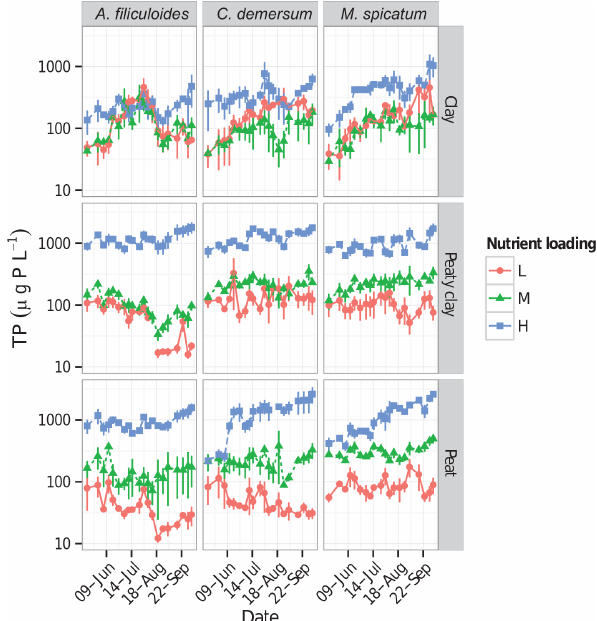
Figure 1. Surface water total P (TP) concentrations sub- jected to different nutrient loadings (L: 0.43mgPm − 2 d − 1 ; M: 21.4mgPm − 2 d − 1 ; H: 85.7mgPm − 2 d − 1 ) in mesocosms with different plant species (vertical panels) on clay, peaty clay or peat sediments (horizontal panels) during the experiment. Average TP concentrations are given with standard error of the mean (SEM). Note the log 10 scale for the y